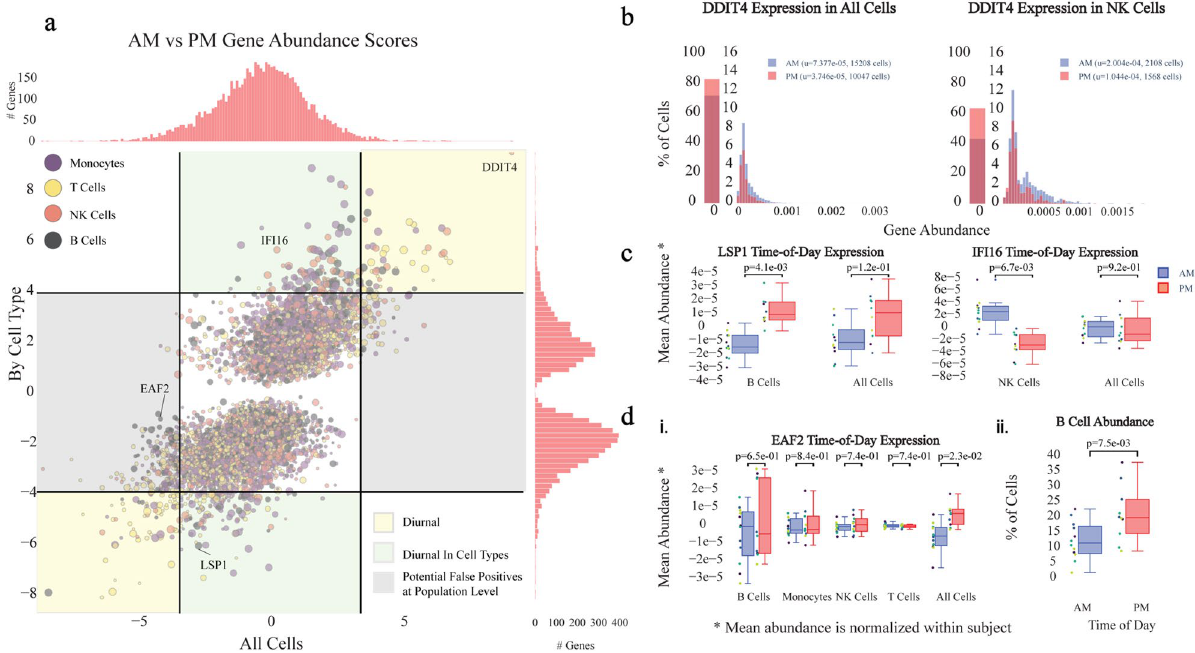
Figure 2. Diurnal variability in subpopulations of capillary blood ( a ) Magnitude (Z-score) of the difference in AM vs PM gene expression across the whole population of cells (x) vs the cell type with the largest magnitude Z-score (y). Points above or below the significance lines (FDR < 0.05, multiple comparison correction) display different degrees of diurnality. The size of each marker indicates the abundance of the gene (the largest percent of cells in a subpopulation that express this gene). ( b ) Distribution of expression of DDIT4, a previously identified circadian rhythm gene 22 , shows diurnal signal across all cells, as well as individual cell types, such as natural killer (NK) cells. u indicates the mean fraction of transcripts per cell (gene abundance). ( c ) Example of newly identified diurnal genes, LSP1 and IFI16 that could be missed if analyzed at the population level ( d ) Example of a gene, EAF2, that could be falsely classified as diurnal (i) without considering cell type subpopulations due to a diurnal B cell abundance shift